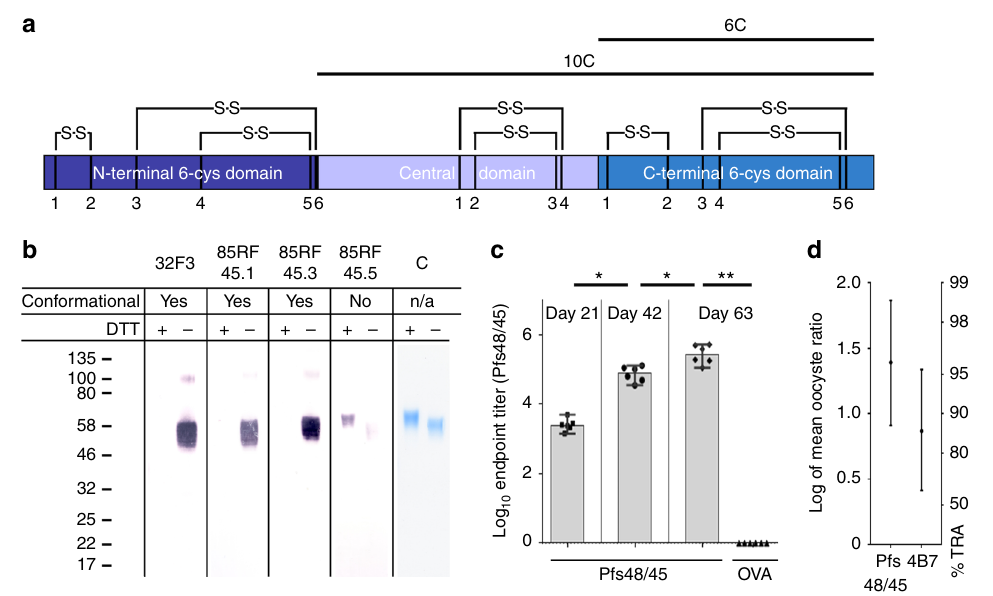
Fig. 1 Full-length Pfs48/45 can be expressed in native conformation by S2 cells. a Domain structure of Pfs48/45. Length of bars is proportional to the number of amino acids in each domain. Disulphide bonds are drawn based on sequence homology to other 6-Cys domain proteins and numbered for each individual domain. b Western blots and Coomassie gel of full-length Pfs48/45. The protein was run on 4 – 12% Bis-Tris polyacrylamide gels in the presence and absence of dithiothreitol (DTT) and stained with Coomassie brilliant blue ( c ) or blotted on nitrocellulose membranes and detected with Pfs48/45- speci fi c monoclonal antibodies (32F3, 85RF45.1, 85RF45.3 and 85RF45.5, at a concentration of 1 µ g/ml). c Anti-Pfs48/45 IgG end point titres in mouse serum after immunisation with Pfs48/45 or chicken ovalbumin (OVA) ( n = 6). Data points show end point titres in individual mice determined by Pfs48/ 45 end point ELISA, bars show median, error bars show 95% CI. Anti-Pfs48/45 IgG titres after consecutive immunisations were compared by Wilcoxon signed-rank test, day 63 anti-Pfs48/45 IgG titres induced by immunisation with Pfs48/45-FL and OVA, respectively, were compared by Mann – Whitney test, * p < 0.05, ** p < 0.005. d Transmission-reducing activity of puri fi ed IgG from mice immunised with Pfs48/45 was determined relative to puri fi ed IgG from mice immunised with OVA at 750 µ g/ml. Transmission-blocking mAb 4B7 was used as a positive control at a concentration of 94 µ g/ml. Data points show transmission-reducing activity (TRA) calculated from the oocyst counts in 20 mosquito midguts, error bars show 95%